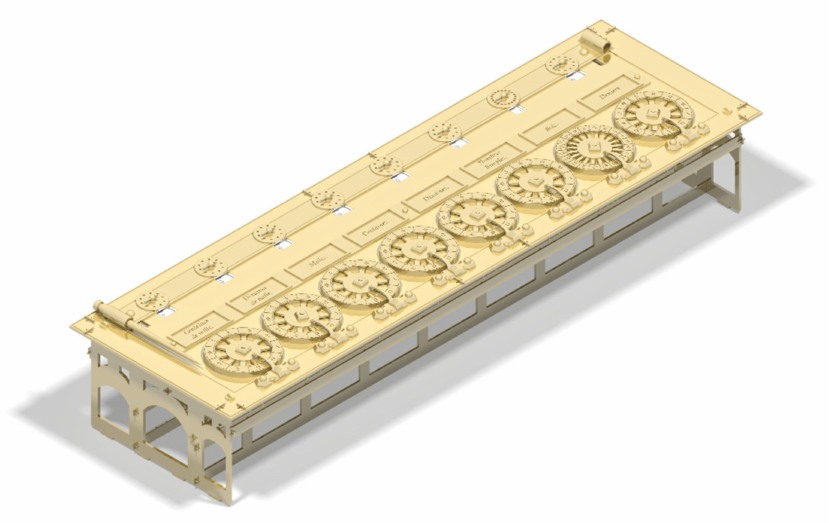
Figure 24. Location of the lid on the